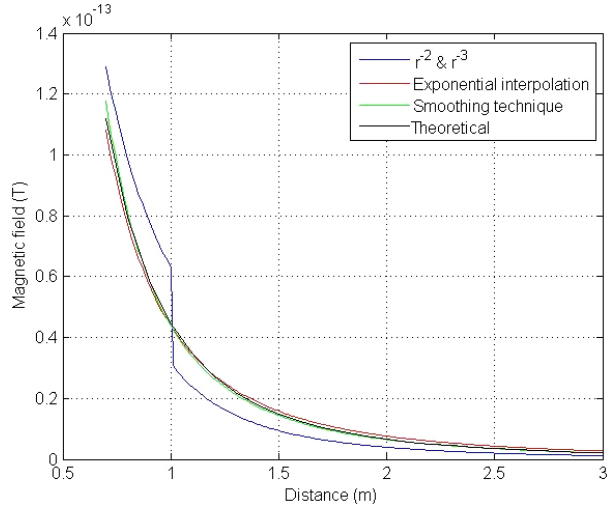
Figure 8. Magnetic field’s prediction with respect to the distance with fixed magnetometers’ location at 25 and 55cm, using several techniques (dimensions 20 × 20 × 20cm 3 ).